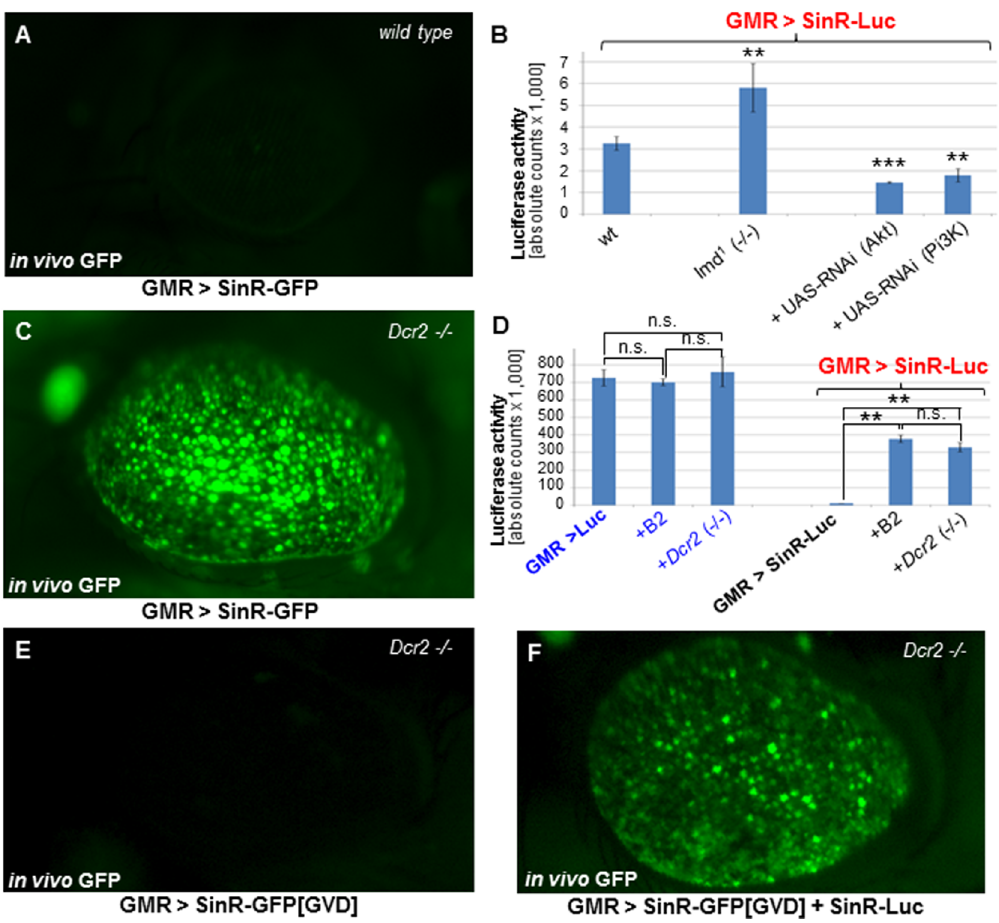
Figure 2. Qualitative and quantitative reporters of invivo viral replication. A. Adult, anesthetized flies expressing SinR-GFP using eye- specific driver GMR-GAL4. Virtually no GFP expression is detectable. B. Quantification of viral replication in vivo , using Luciferase-expressing, replication-competent replicon SinR-Luc. Mutations in imd resulted in significantly higher activity. In contrast, knock-down of Akt and Pi3K using UAS- RNAi constructs resulted in a significant decrease. (Luminometer counts in relative units per fly, per m L of homogenate). C. Strong GFP expression can be observed in the entire eye, when RNAi is inhibited using homozygous Dcr2 mutants. D. Quantification of RNAi effects on viral replication in vivo , using SinR-Luc in combination with different ways of inhibiting RNAi (UAS-B2 co-expression, homozygous Drc2 mutants). Inhibition of RNAi greatly increased SinR-Luc activity. Note that UAS-Luciferase control levels are unaffected by suppression of RNAi. E. SinR-GFP[GVD] with a point mutated RNA-dependent RNA Polymerase never results in GFP expression as detected by in vivo fluorescence. F. Rescue of GFP expression from SinR- GFP[GVD] in trans , using GMR-GAL4, through co-expression of non-fluorescent replicon SinR-Luc, providing an active replicase.